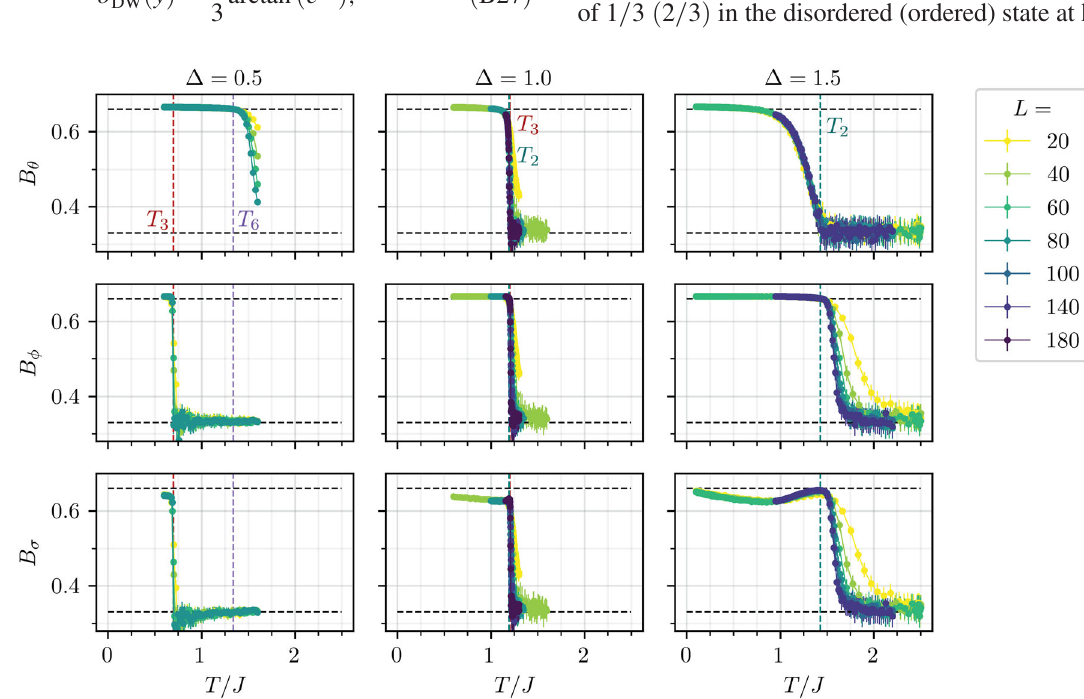
FIG. 10. Binder cumulants B θ , B ϕ , B σ of hexatic θ , nematic ϕ , and relative σ ¼ ð θ − 3 ϕ Þ = 3 degrees of freedom as a function of the temperature T=J . Different columns denote different values of Δ ¼ 0 . 5 , 1.0, 1.5 as indicated. Vertical lines indicate the location of transition temperatures T 3 (Potts), T 6 (KT hexatic), and T 2 (KT